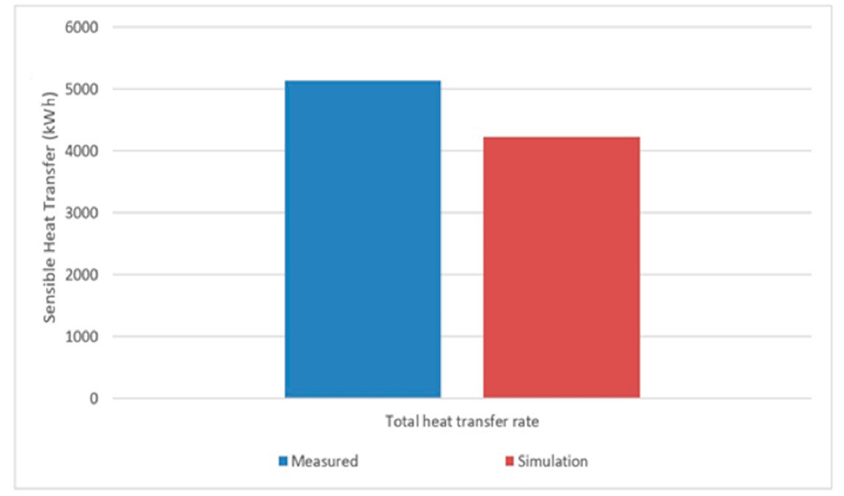
Figure 11. The measured and simulated sensible heat transfer (kWh).